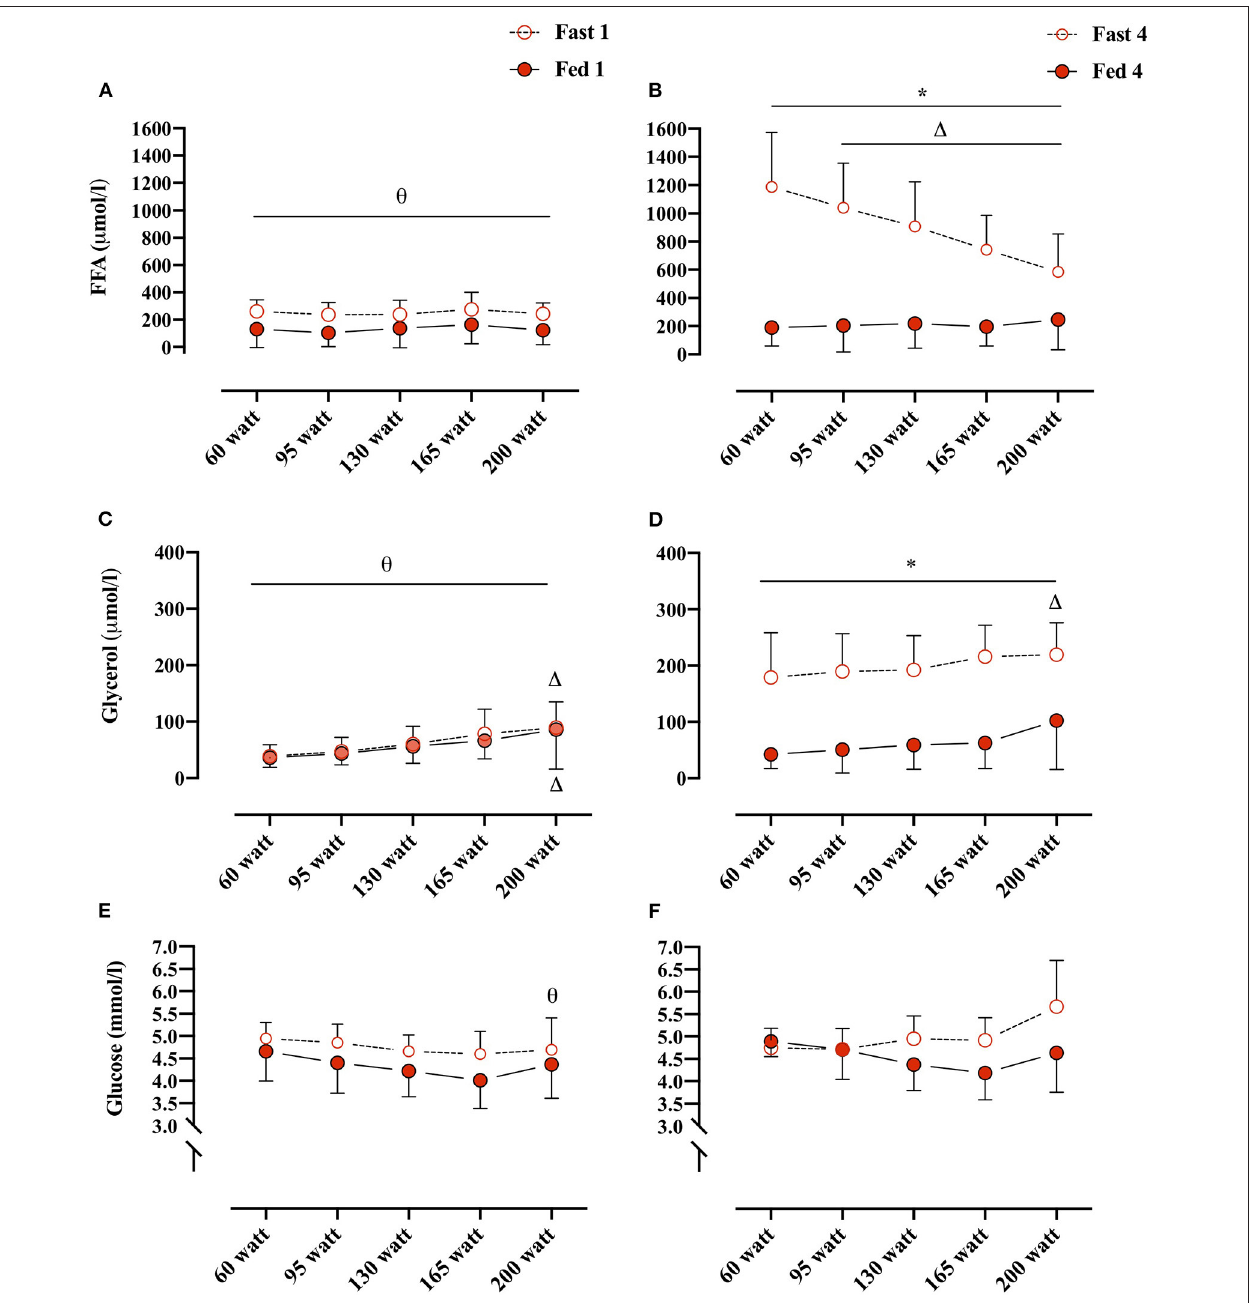
FIGURE 3 | (A,B) Plasma FFA concentrations ( µ mol/L) at, 60, 95, 130, 165, and 200W during Fed 1 (open red circles), Fast 1 (closed red circles) and Fed 4 (open red circles), Fast 4 (closed red circles), respectively. (C,D) Plasma glycerol concentrations ( µ mol/L)/workload (W) during Fed 1, Fast 1 and Fed 4, Fast 4, respectively. (E,F) Plasma glucose concentrations (mmol/L)/workload (WL) (W) during Fed 1, Fast 1 and Fed 4, Fast 4, respectively. *, difference between condition within test number and WL; 1 , difference from 60W within test number and condition; θ , difference between test number within condition and WL. 60 W: Fast 1, n = 10, Fed 1, n = 11; 95 W: Fast 1, n = 10, Fed 1, n = 11; 130 W: Fast 1, n = 9, Fed 1, n = 11; 165 W: Fast 1, n = 10, Fed 1, n = 9; 200 W: Fast 1, n = 7, Fed 1, n = 6. 60 W: Fast 4, n = 9, Fed 4, n = 8; 95 W: Fast 4, n = 10, Fed 4 and 8; 130 W: Fast 4, n = 9, Fed 4, n = 8; 165 W: Fast 4, n = 10, Fast 4, n = 7; 200 W: Fast 4, n = 7, Fed 4, n = 6. Data are presented as mean ± SD (error